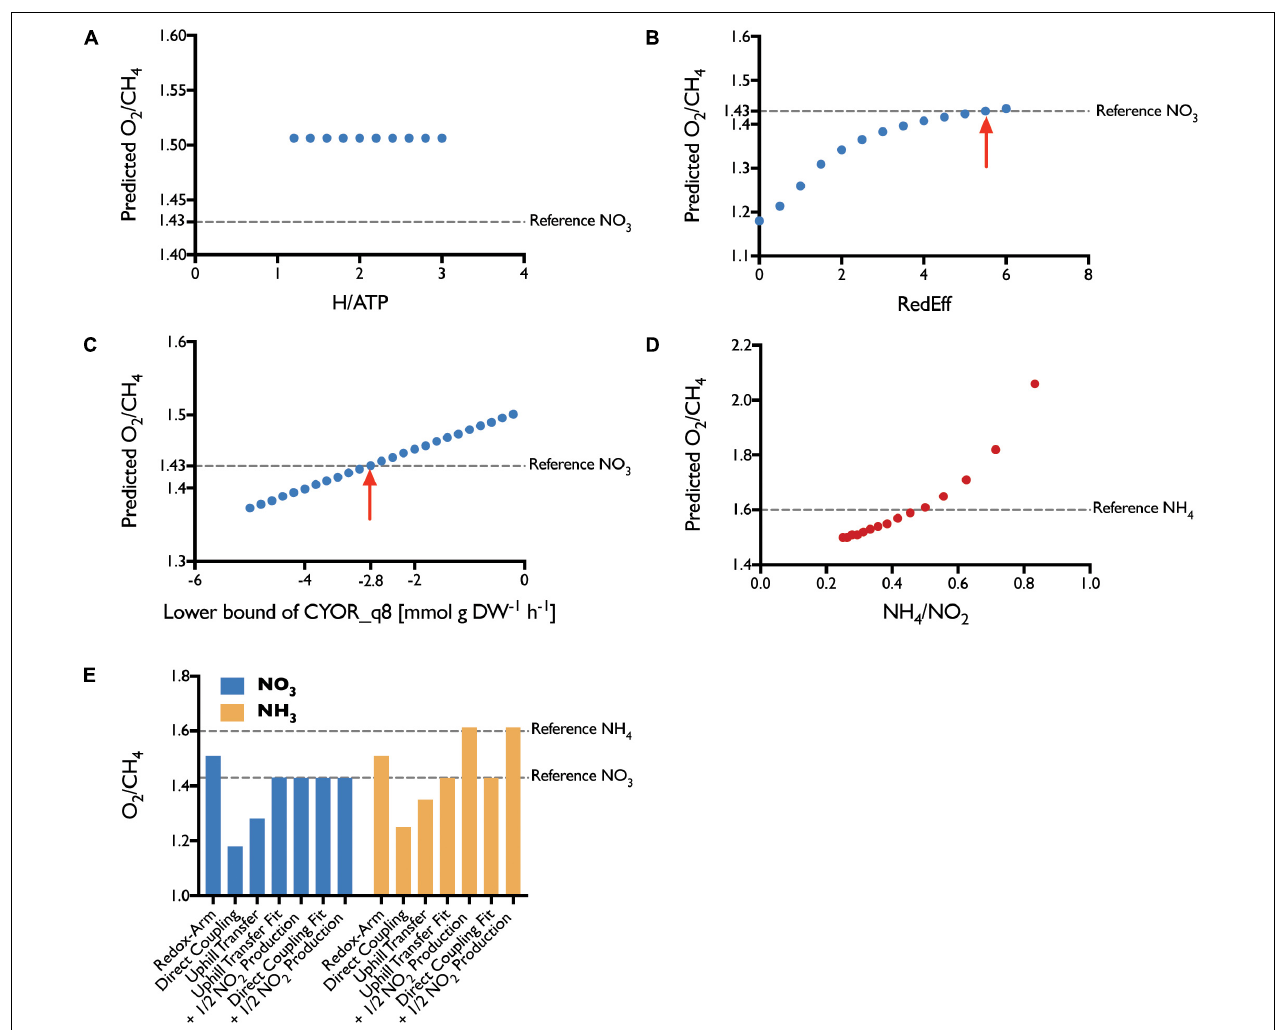
FIGURE 7 | Parameter Fit. The efficiency of each transfer mode was varied iteratively to determine the best fit. (A) For the redox-arm mode we varied the ratio of protons required per synthesis of 1 mol ATP, with no effect. (B) Fitting the direct-coupling mode, we forced a portion of the flux through the PMMOipp reaction. The red arrow marks the best fit with 5.5 times more carbon flux through PMMOipp than PMMODCipp. (C) The Uphill-electron transfer was fit by allowing reverse flux through the ubiquinol-cytochrome c reductase (CYOR_q8) reaction. The red arrow marks the best fit at a lower bound of – 2.8 mmol g DW - 1 h - 1 . (D) To account for energy loss through NH 3 oxidation, several ratios of NH 4 uptake to NO 2 production were considered. The closest fit was achieved with a ratio of around 0.5. (E) Without reducing electron transfer efficiency none of the modes could fit the reference value for NO 3 . For NH 3 , the reference was met after accounting for the effect of NH 3 oxidation to NO 2 . Reduced efficiency uphill electron transfer and direct coupling both allow prediction of O 2 /CH 4 ratios that agree well with the literature